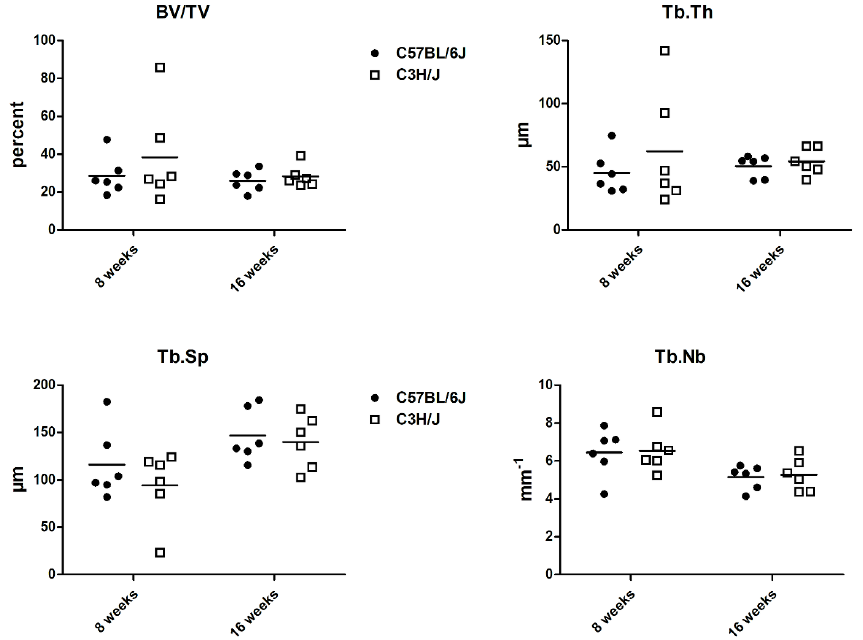
Figure 3. Histomorphometric data of C57BL/6J and C3H/J mice at 8 and 16 weeks of age. BV/TV: bone volume/tissue volume; Tb.Th: trabecular thickness; TbSp: trabecular separation; TbNb: trabecular number.